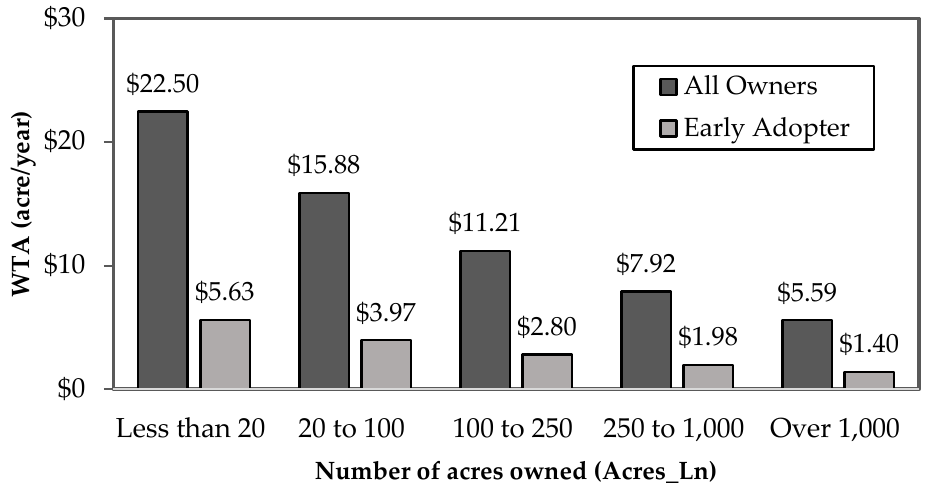
Figure 1. Willingness to accept payment for forest carbon based on number of acres owned (acre/year).